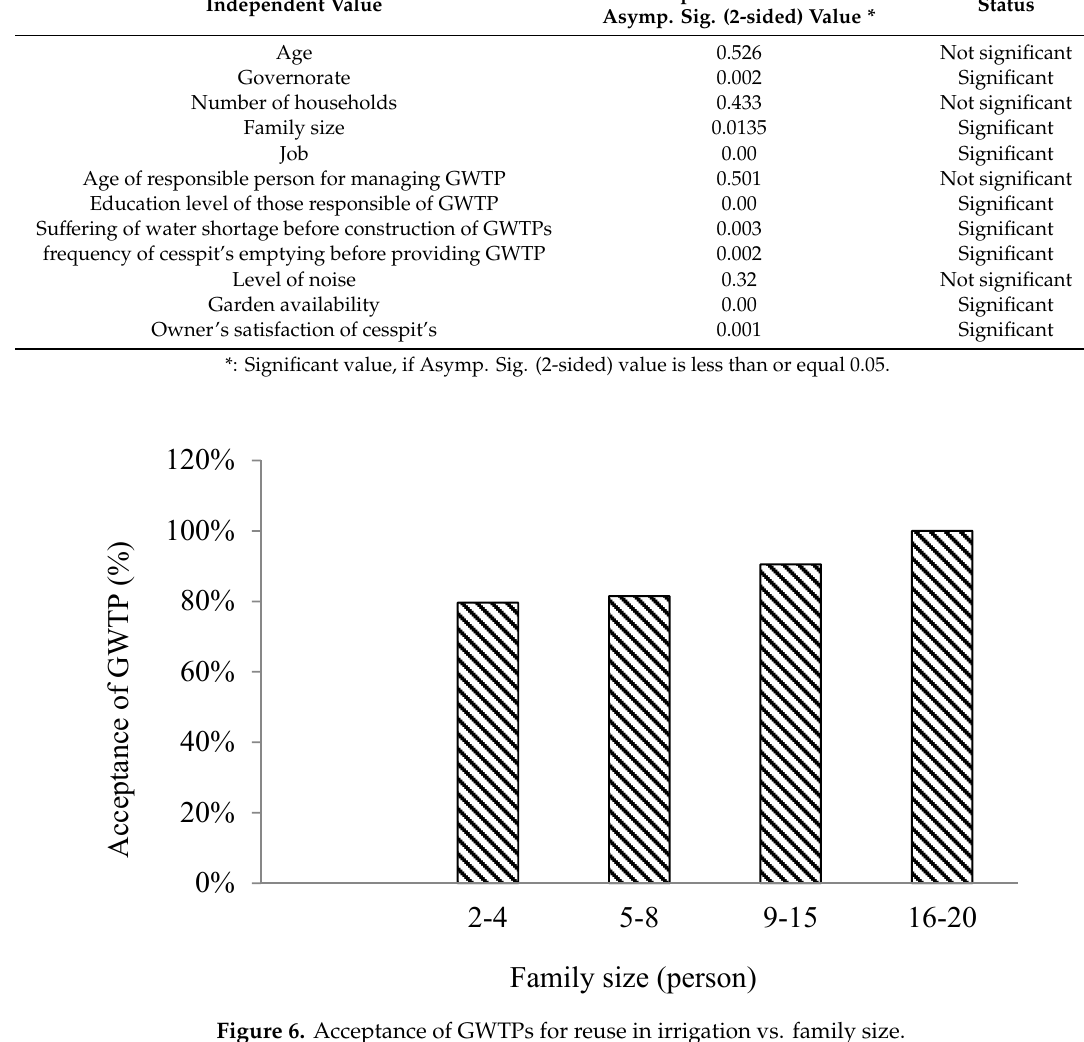
Table 3. Acceptance of GWTPs for reuse in irrigation versus job.